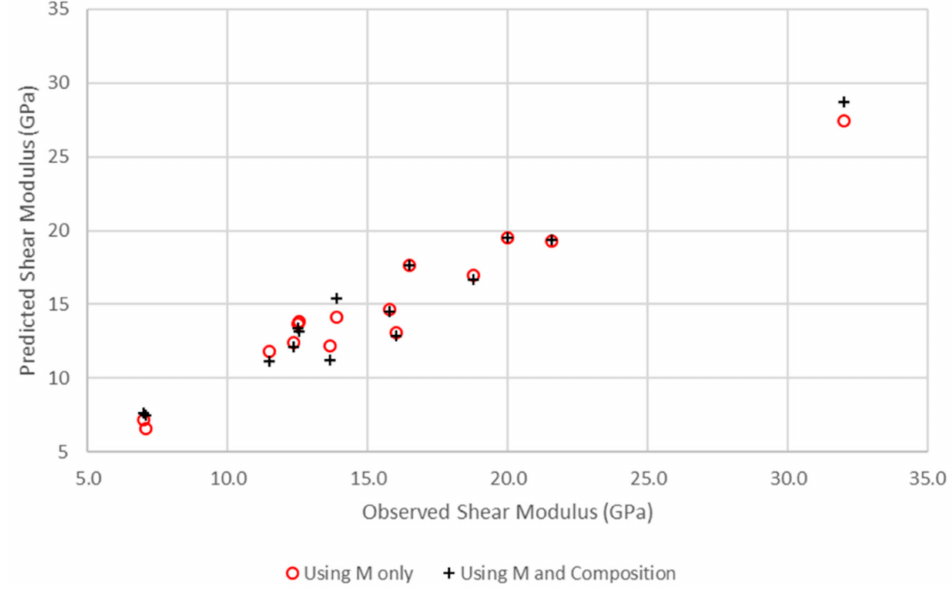
Figure 13. Comparison of predicted and observed dynamic shear moduli for the out-of-sample literature data provided in Table 6. The open red circles are for predicted shear moduli made only with P-wave modulus with Equation (7). The black plus signs are for predicted shear moduli using P-wave modulus and volume fractions of solid organic matter, clay, and carbonate with Equation (8). The predictions are excellent excepting the single datapoint with anomalously high shear modulus. The standard error is 1.5 GPa using Equation (8) and 1.6 GPa using Equation (7). R 2 is 0.95 for both